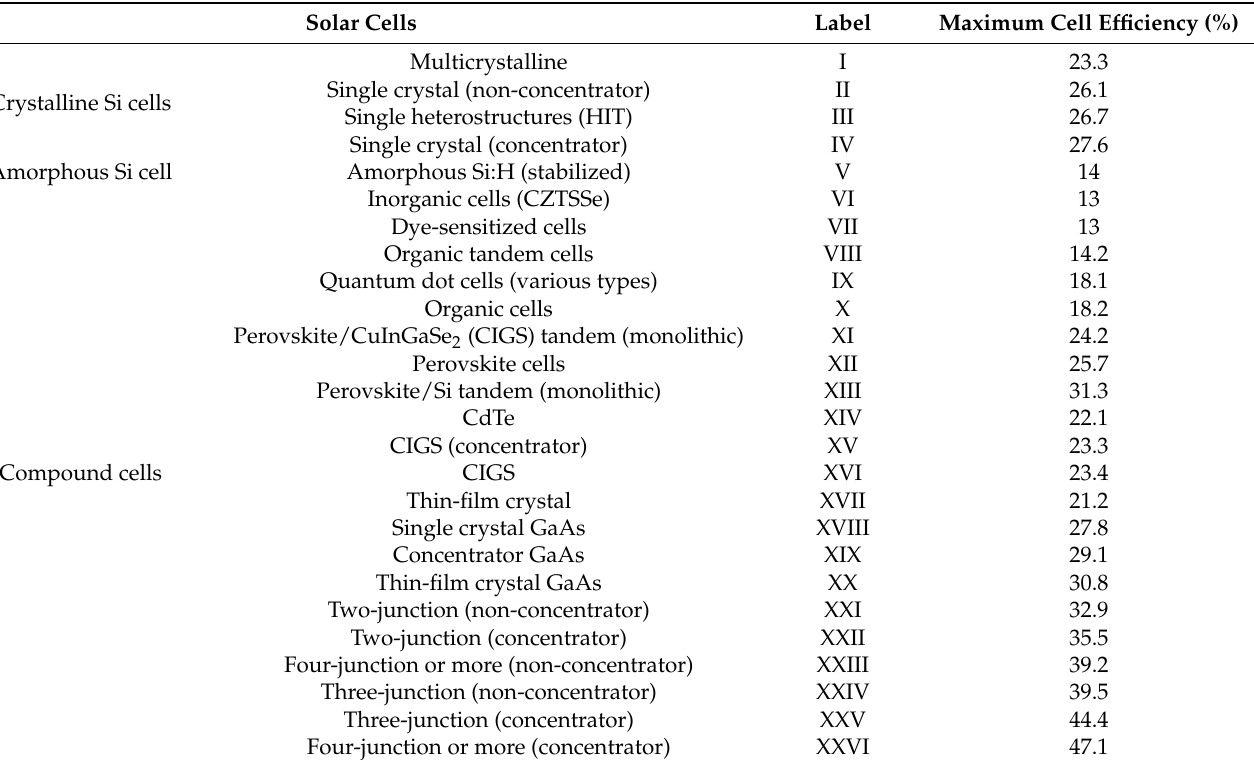
Table 1). Among the various types of PVCs, crystalline silicon solar cells have proven to be the most commercially successful PVC technology due to their capability to provide high efficiency with affordable costs, and the great availability of silicon material on the earth [22]. Table 1. The highest confirmed conversion efficiencies and categories of different solar cells. Source: National Renewable Energy Laboratory (NREL), https://www.nrel.gov/pv/cell-efficiency.html, accessed on 30 June